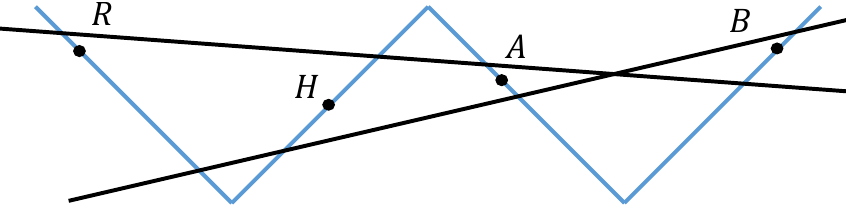
Figure 9 . We consider the situation considered by AMPS, but in the HM proposal. System H which is entangled with reference frame R , is initially inside the black hole, and is teleported out of it through entanglement formed by the infalling A and outgoing B Hawking pair. For any intermediate measurement made on the systems, the order doesn’t